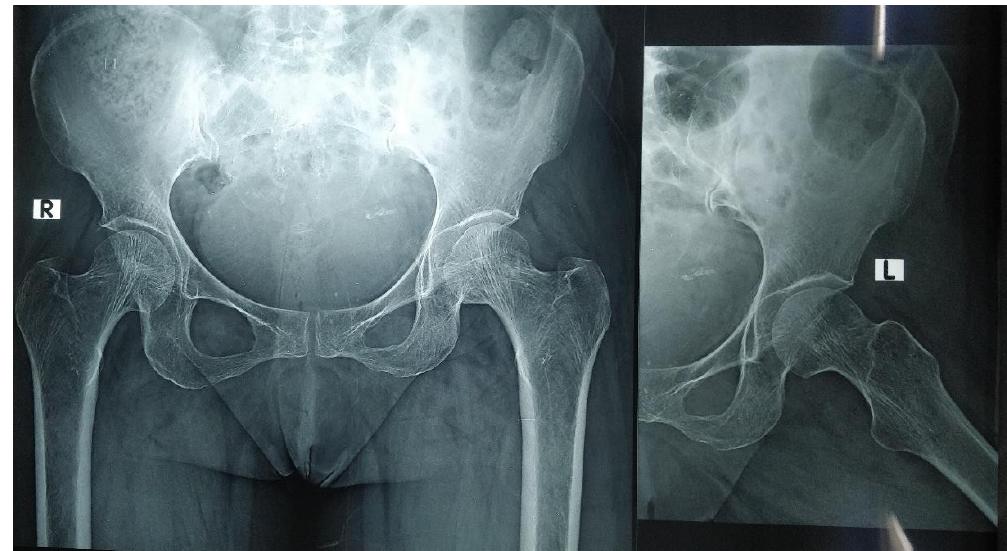
Figure 2: X-ray bilateral hip joints AP view